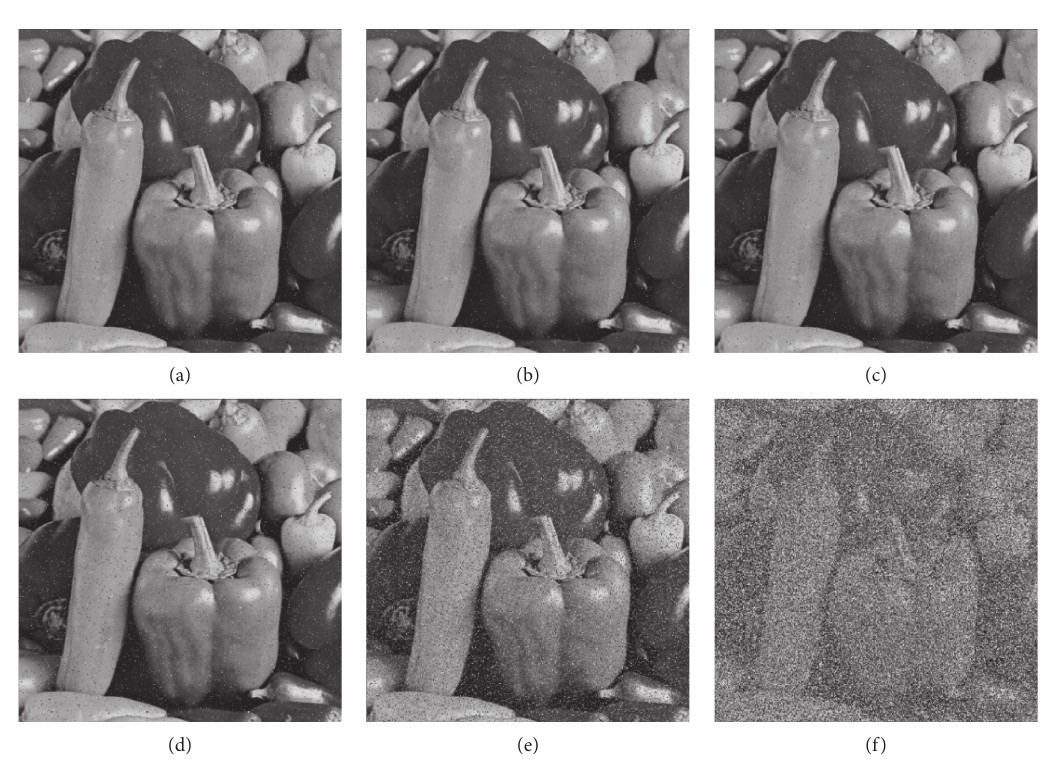
Figure 15: Gaussian noise (a)–(c) and salt and pepper noise (d)–(f) results. (a) Variance is 0.0001; (b) variance is 0.0003; (c) variance is 0.0005; (d) density is 0.01; (e) density is 0.05; (f) density is